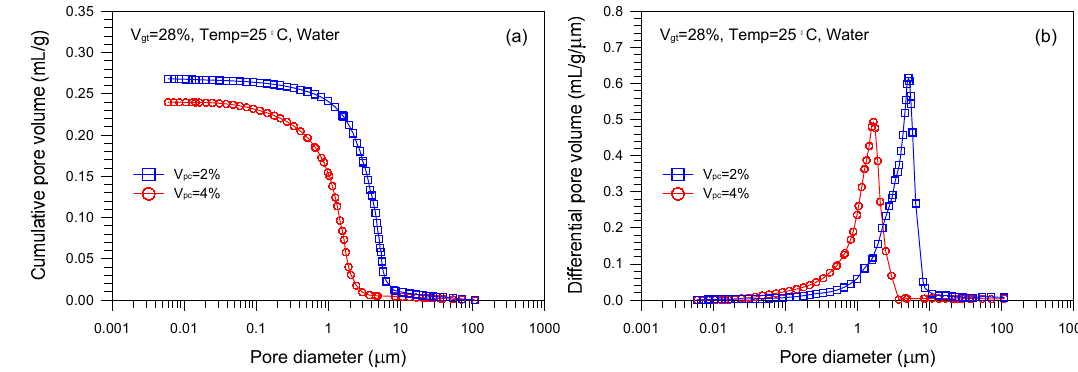
Figure 4. Effect of cement volume fraction on pore size distribution of cement-stabilized tailings: ( a ) cumulative intrusion curve, ( b ) differential instruction curve.